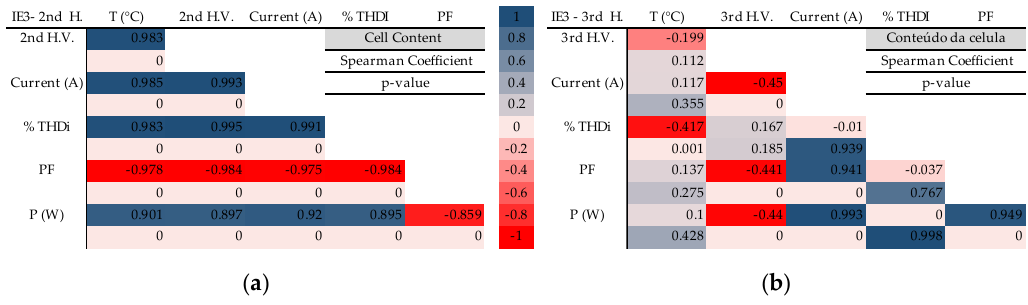
Figure 14. Correlation matrix between temperature and input parameters in IE3 class SCIM for ( a ) second harmonic voltage distortion; ( b ) third harmonic voltage distortion.